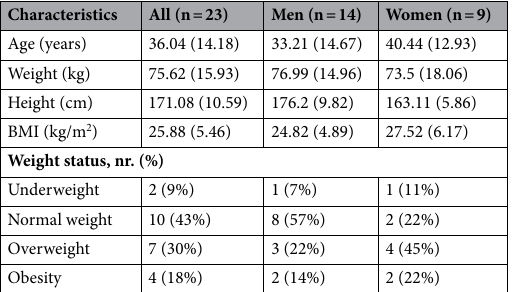
Table 1. Descriptive characteristics of participants. Data presented as mean (SD) or frequency (percentage) as appropriate. BMI body mass index, SD standard